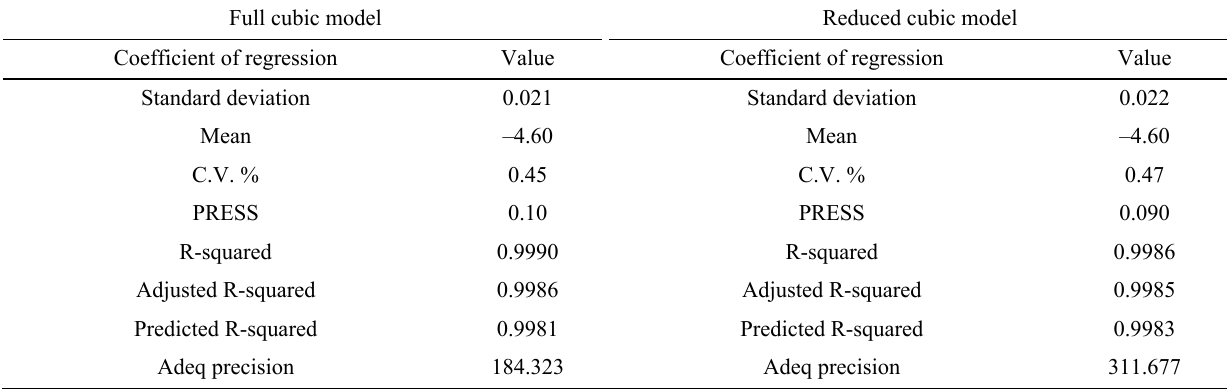
Table 7 Values of coefficient for full and modified cubic models from ANOVA